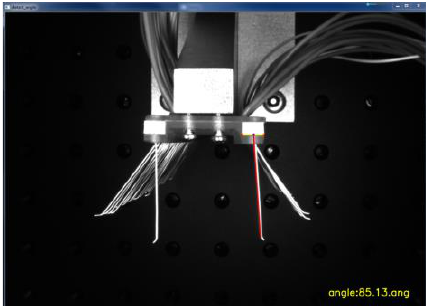
Figure 14. Brush wire clamping angle value detection diagram.